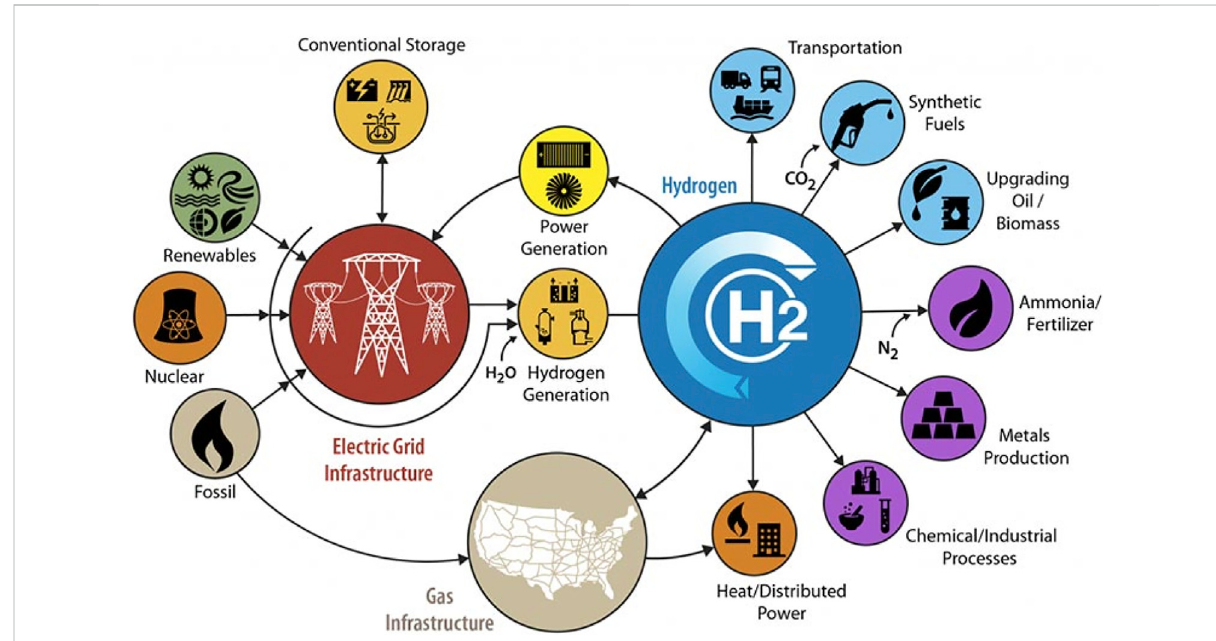
FIGURE 2 SchematicillustrationoftheH2@ScaleconceptshowingthediverserangeofH 2 applications,suchasenergystorage,thermalheating,industrial processes, transportation, and electricity production (Pivovar et al.,